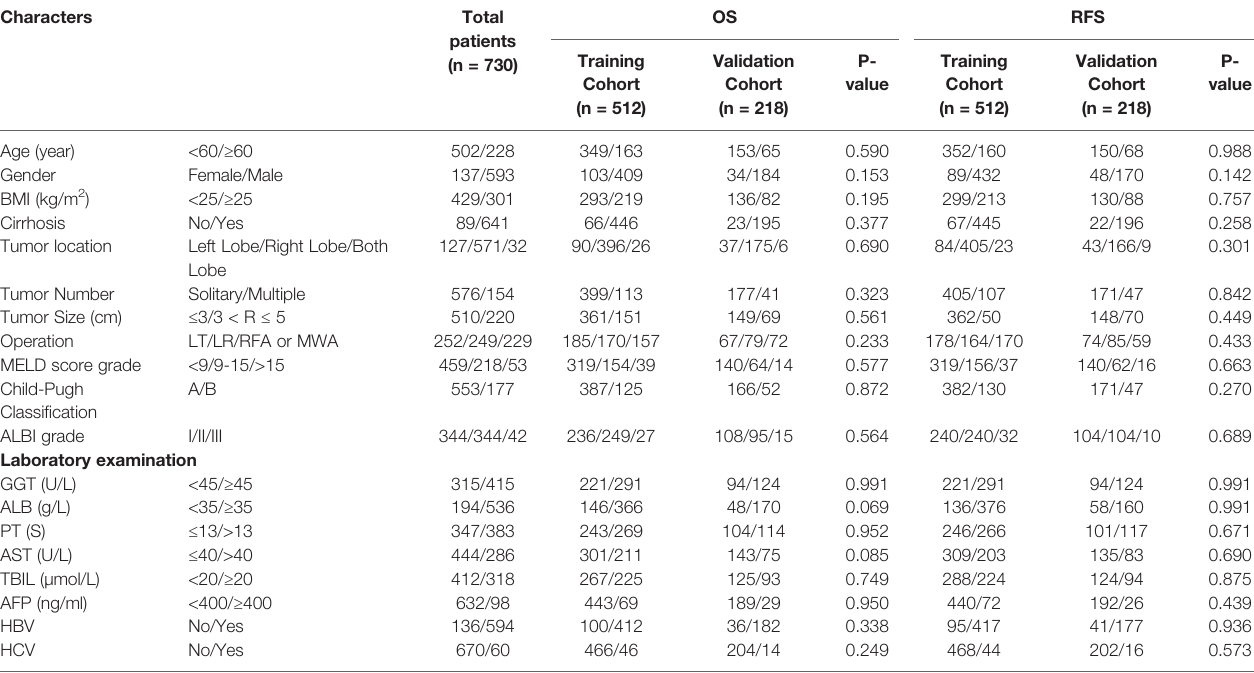
TABLE 1 | Demographic and clinical characteristics of